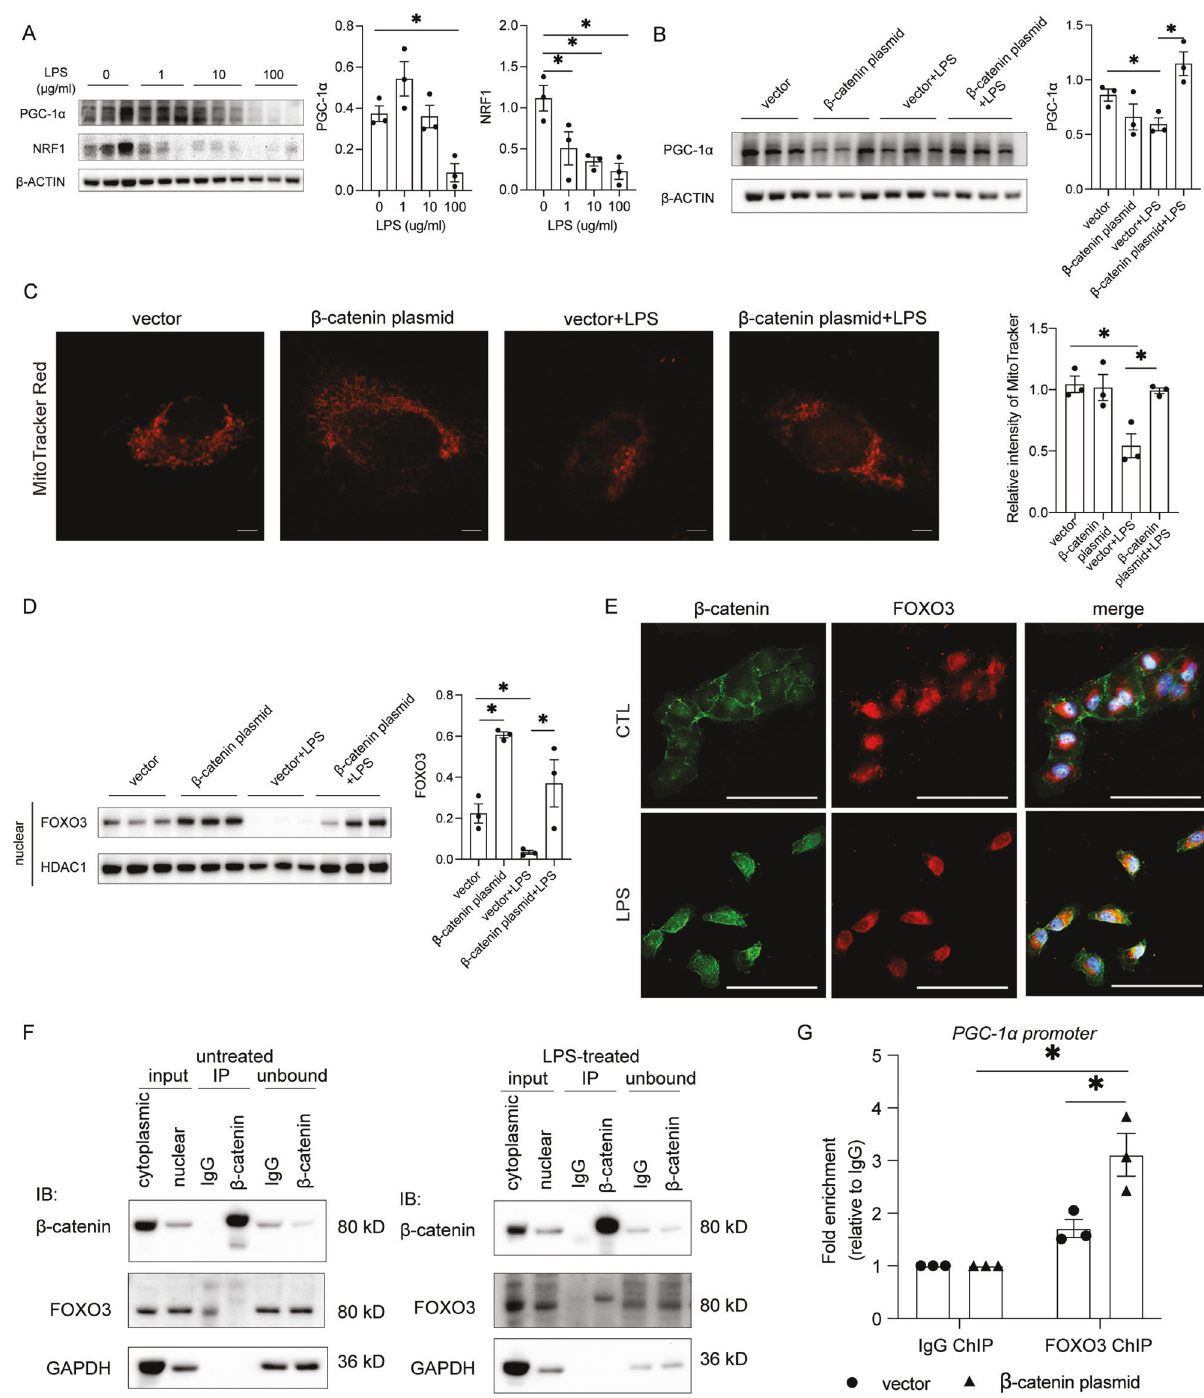
Fig. 8 β -catenin enhanced FOXO3-dependent PGC-1 α transcription that drives mitochondrial biogenesis upon LPS treatment in HK-2 cells. A PGC-1 α , NRF1 protein expression and quanti fi cation upon different dose of LPS (0, 1, 10, and 100 μ g/ml) for 3 h. * p < 0.05; n = 3 in each group. B Representative western blot and quanti fi cation on PGC-1 α expression in vector or β -catenin transfected HK-2 cell lysate under LPS stimulation. * p < 0.05; n = 3 in each group. C Representative MitoTracker Red staining and intensity quanti fi cation in vector or β -catenin plasmid transfected HK-2 cells under LPS stimulation. Scale bar = 5 μ m. * p < 0.05; n = 3 in each group. D Nuclear FOXO3 expression and quanti fi cation in HK-2 cell nuclear fraction upon β -catenin overexpression. * p < 0.05; n = 3 in each group. E Co-immuno fl uorescence staining of β -catenin (green) and FOXO3 (red) in HK-2 cells with or without LPS stimulation (100 μ g/ml, 30 min). DAPI (blue) is used for nuclear staining. Scale bar = 100 μ m. F Co-immunoprecipitation result on nuclear fraction of β -catenin overexpressing HK-2 cell in untreated or LPS-treated condition with β -catenin antibody and immunoblots with FOXO3. G Chromatin immunoprecipitation-qPCR showed FOXO3 binding to the promoter region ( − 1242 from TSS) of PGC-1 α in HK-2 cells with β -catenin overexpression. * p < 0.05; n = 3 in each group. TSS transcription starting